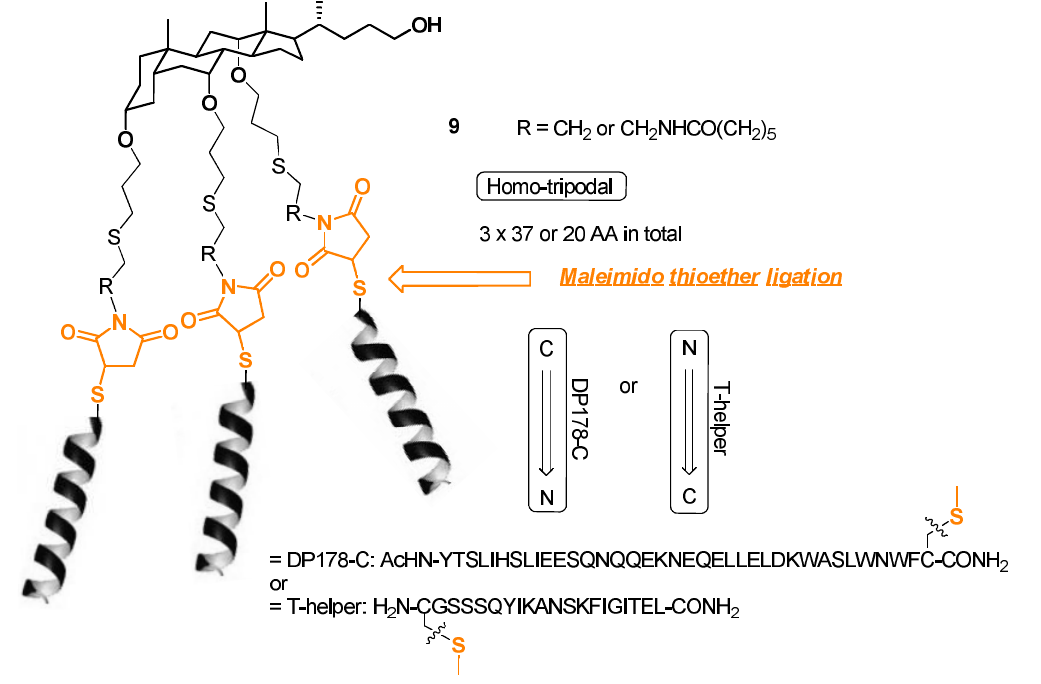
Figure 3. Macromolecular peptidosteroid ligation precedent by Wang et al .